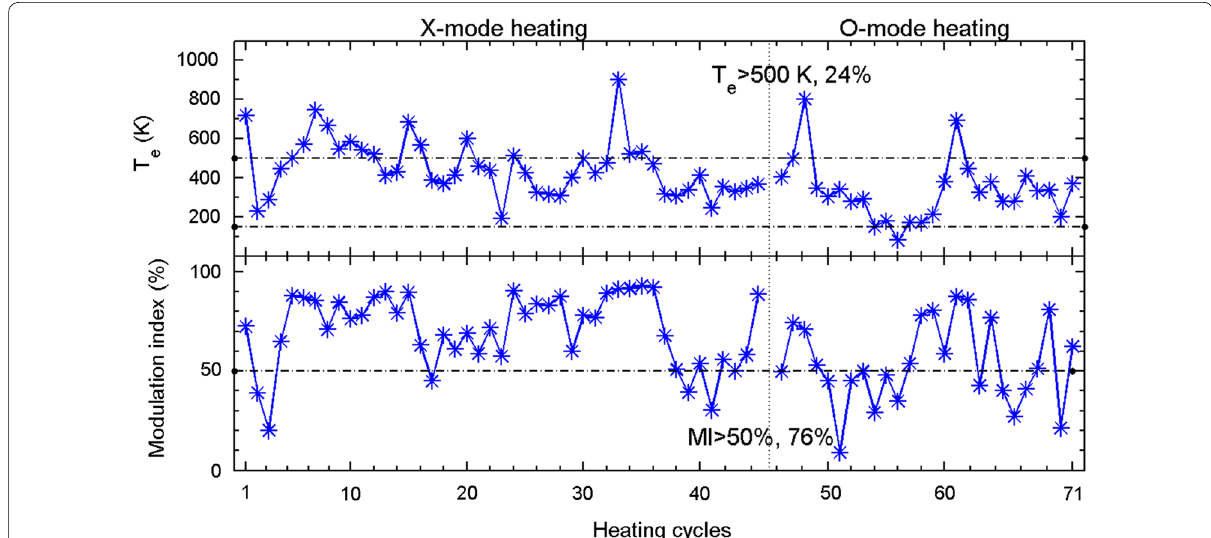
Fig. 10 As for Fig. 7 but for case 3b. In this case, the HF transmitter was operated with one frequency 5.423